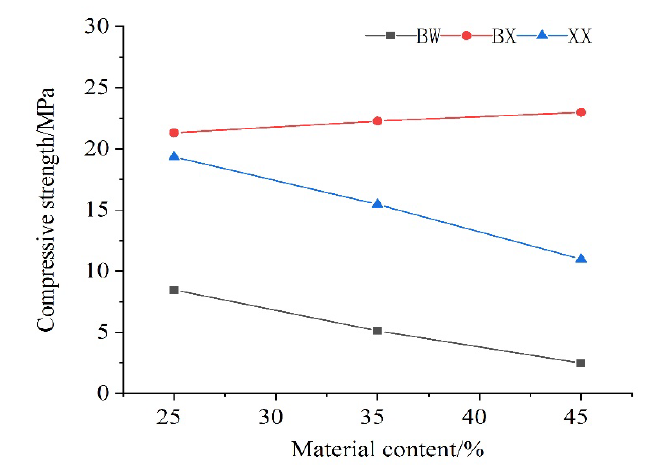
Figure 7. Variation trend of compressive strength with the amount of thermal insulation material.